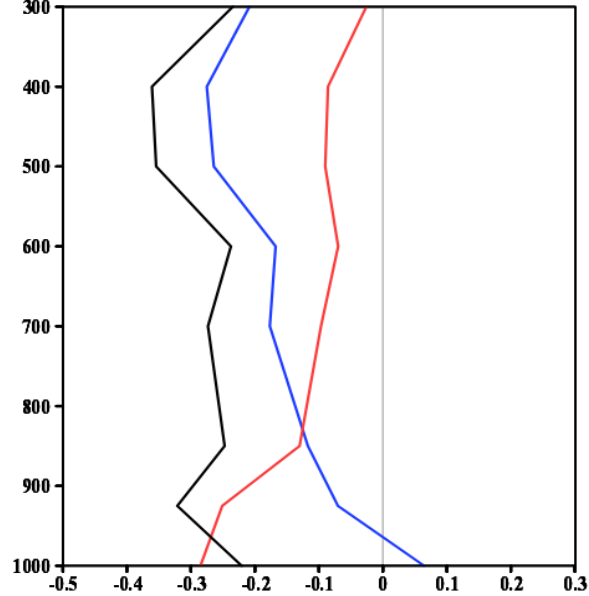
Figure 6. The vertical profiles of the I q (blue), I t (red), and I r (black) from 1000 hPa to 300 hPa. The three measures were calculated with the specific humidity and temperature averaged over the domain (125–131 ◦ E, 44–47 ◦ N) of January–February 2019 relative to the 30-year climatic mean (1981−2010). I r